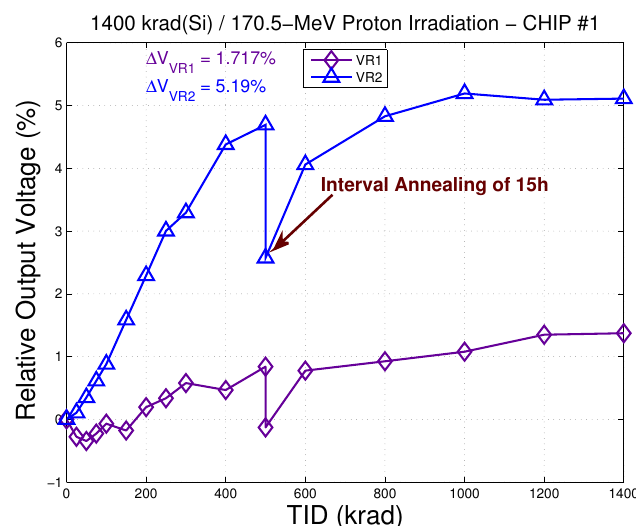
Figure 21. Relative output voltage change (%) of the VR1 and VR2 when exposed to 170.5-MeV Protons irradiation, accumulating a total dose of 1400 krad(Si) with a fluence of 3.9 × 10 11 cm − 2 . An interval annealing step at room temperature was performed at 500 krad(Si).